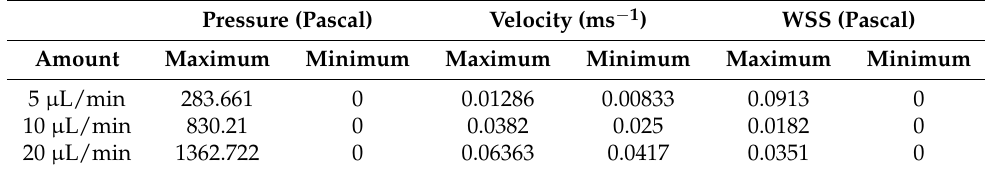
Table 2. Table showing maximum and minimum pressure, velocity and shear